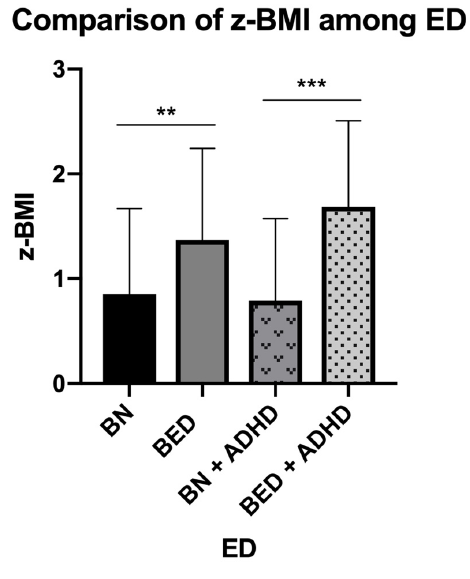
Figure 2. Comparison of z-BMI values among patients with ED and ED-ADHD. Abbreviations: ED, eating disorders; AN, anorexia nervosa; BN, bulimia nervosa; BED, binge eating disorder; ADHD, attention-deficit/hyperactivity disorder. Notes: ** indicates p = 0.017 of a Student’s t -test; *** indicates p = 0.009 of a Student’s t -test.